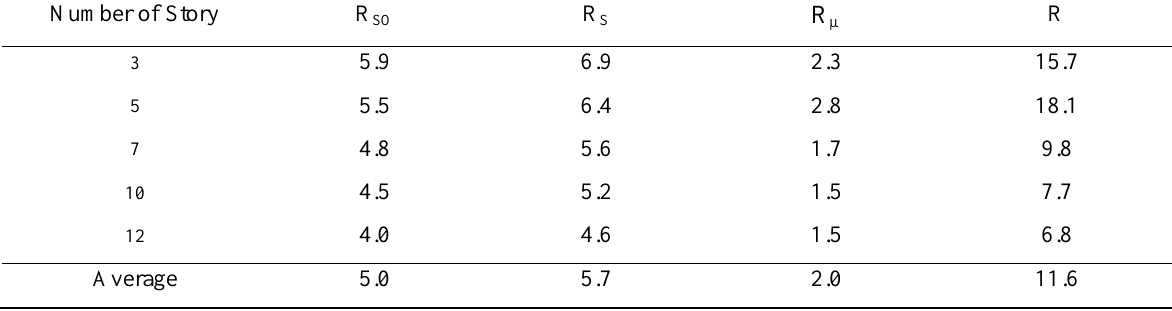
Table. 8. Average of overstrength, ductility and response modification factors of